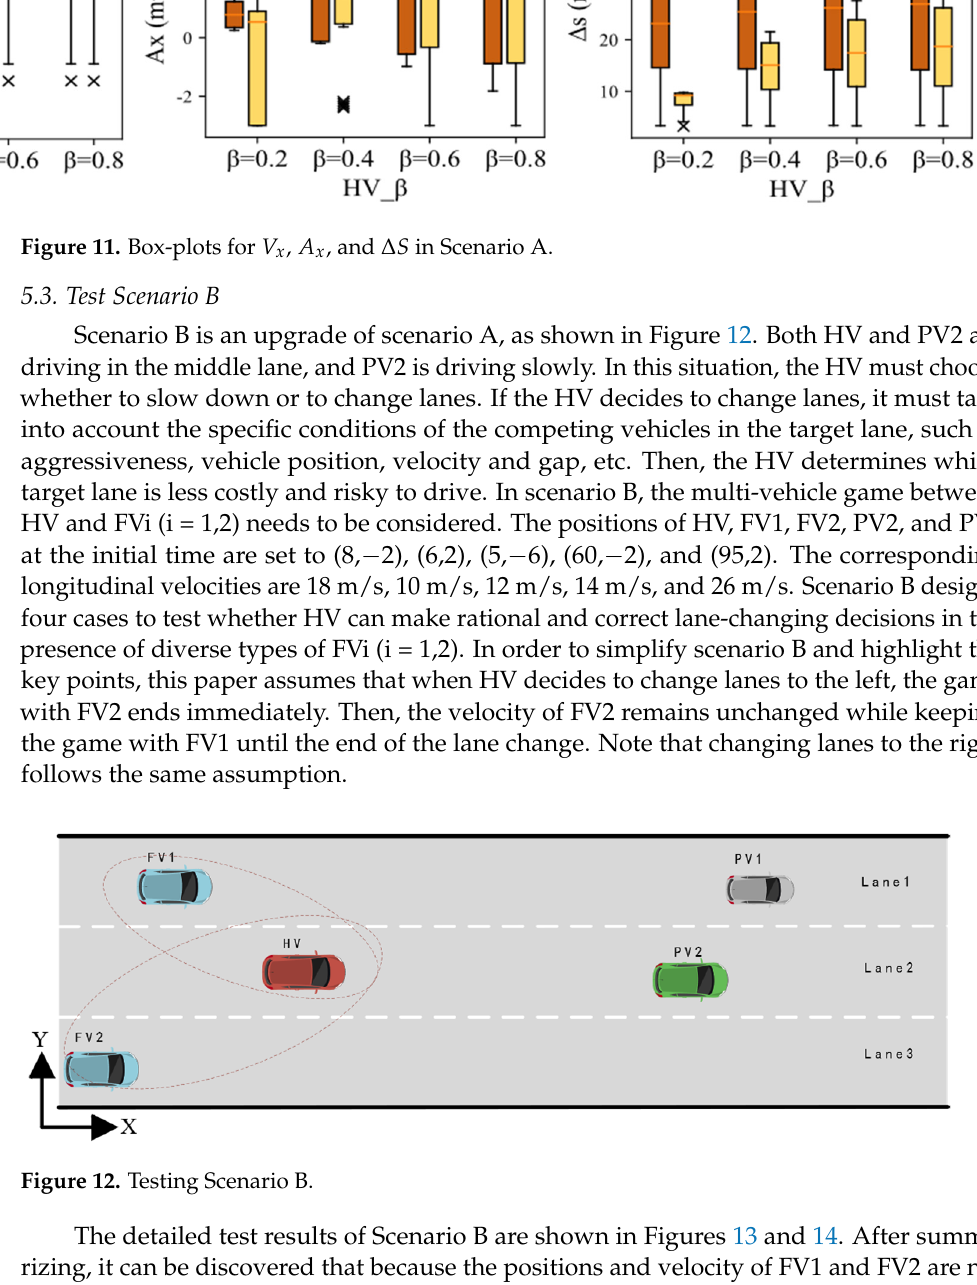
Figure 11. Box-plots for V x , A x , and ∆ S in Scenario A.